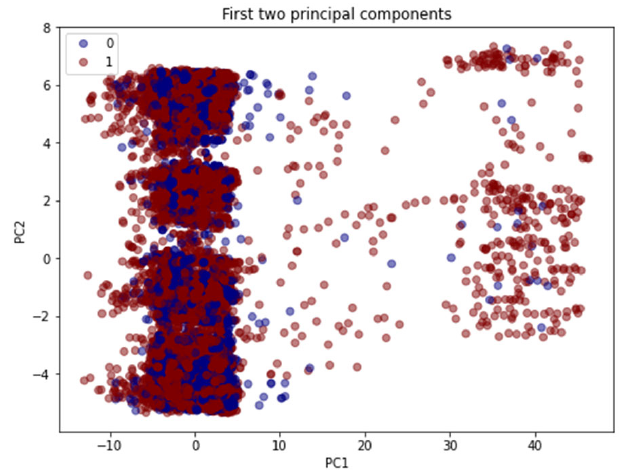
Figure 4. The result of conducting principal component analysis (PCA) on the Morris power Ddataset.